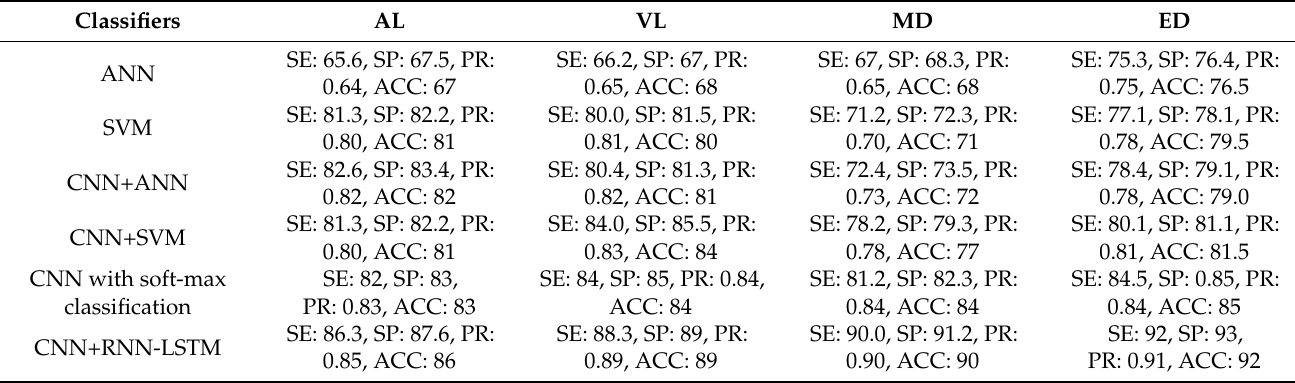
Table 7. Comparisons results based on 4-class based DFD systems by using hybrid deep learning based classifier (CNN and RNN–